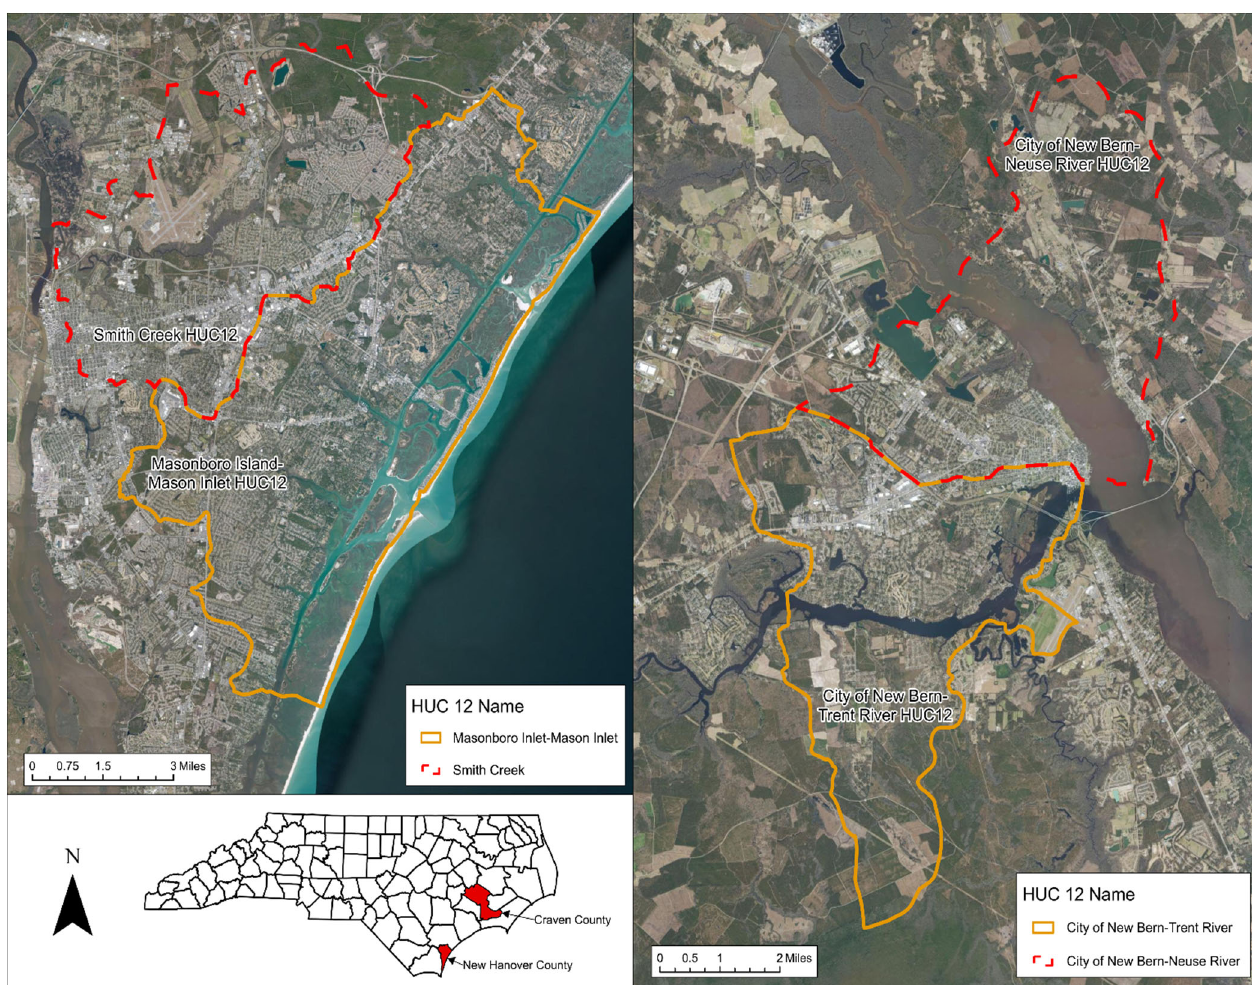
Figure 1. New Hanover County, NC study areas consisting of the Masonboro Island–Mason Inlet and Smith Creek subwatersheds.